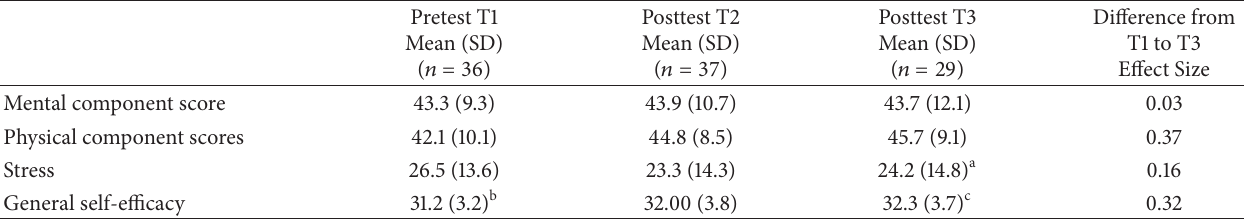
Table 3: Pretest and posttest mean scores, standard deviation (SD), and effect size for scores from T1 to T3 for mental and physical component scores, stress, and general self-efficacy in patients with neuroendocrine tumors (T1, 𝑛 = 36-37; T2, 𝑛 = 37; T3, 𝑛 = 29-30).